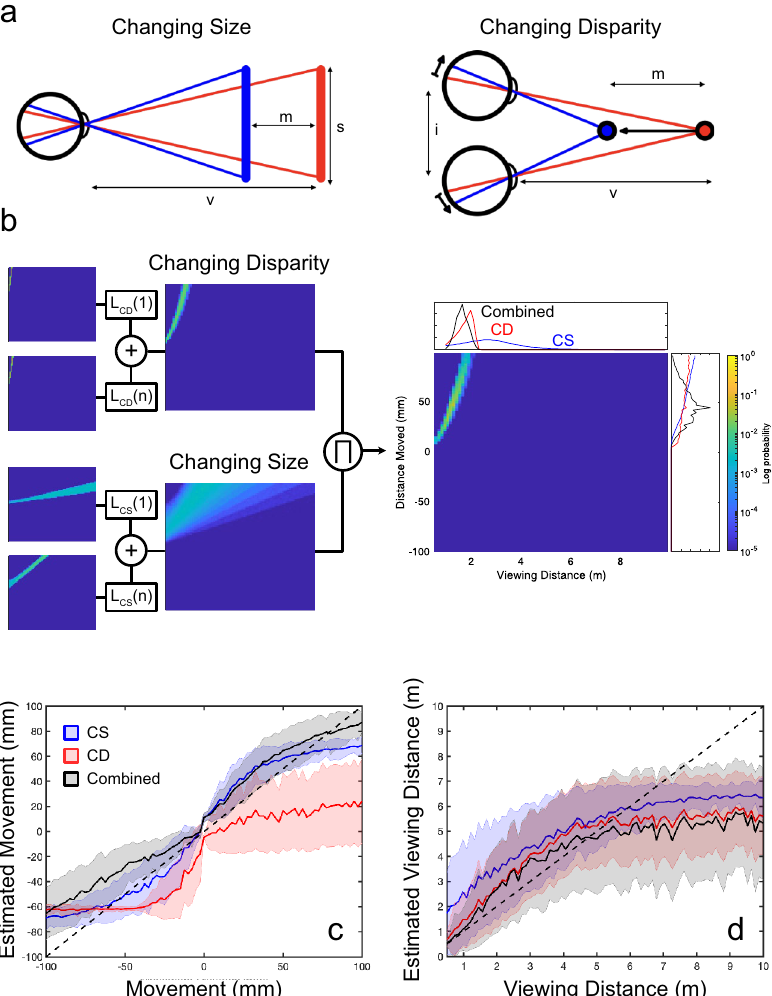
Figure 1. Motion-in-depth cues depend upon multiple scene parameters. ( a ) Motion-in-depth may be signalled by changing image size (CS), which depends on the viewing distance v, object size s and distance moved m, and on changing disparity (CD), which depends upon m, v, and the inter-ocular separation i. ( b ) Given these dependencies, Monte Carlo simulations of linear motion-in-depth reveal a probabilistic relationship between CS, CD, and the likelihood of joint values of m and v. These probabilistic relationships were used to model speed-in-depth perception. Scene parameter distributions for each cue were taken as the weighted sum of posterior distributions given uncertain CD and CS signals. Combined signals were taken as the normalised product of these weighted sum distributions, with scene parameter estimates given by the marginal means (see “Methods” for full details). ( c , d ) Resulting scene parameter estimates for distance moved and viewing distance, respectively, plotted against the true values. Blue, red and black lines show CS, CD and combined estimates, respectively. Shaded areas show standard deviations. These figures show that our model can successfully estimate values of m and v within a near-space